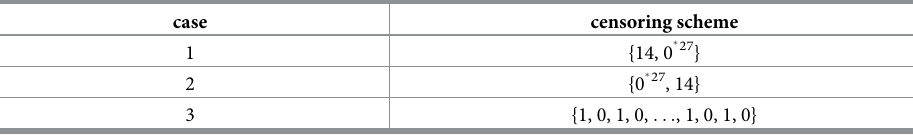
Table 7. Censoring schemes for American Football